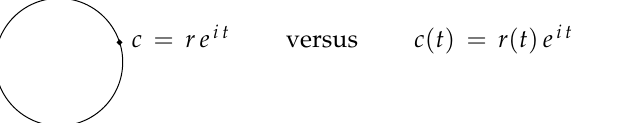
Figure 3. Complex numbers are discrete (as a number) and smooth (as a function),